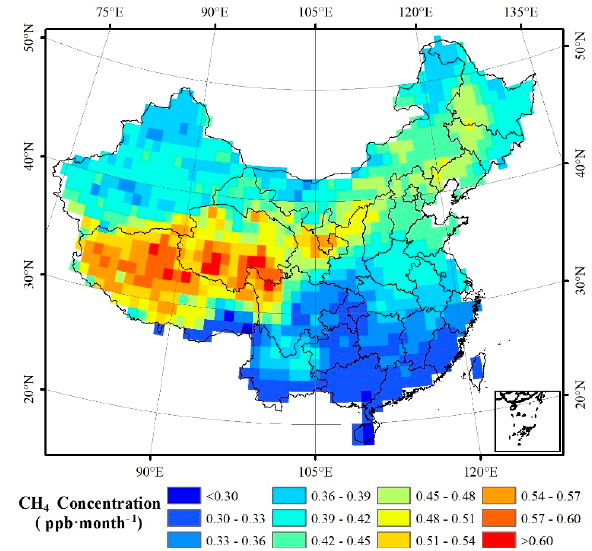
Figure 7. Spatial distributions of the trend in CH 4 concentration at 500 hPa during 2002 to 2016, from AIRS.